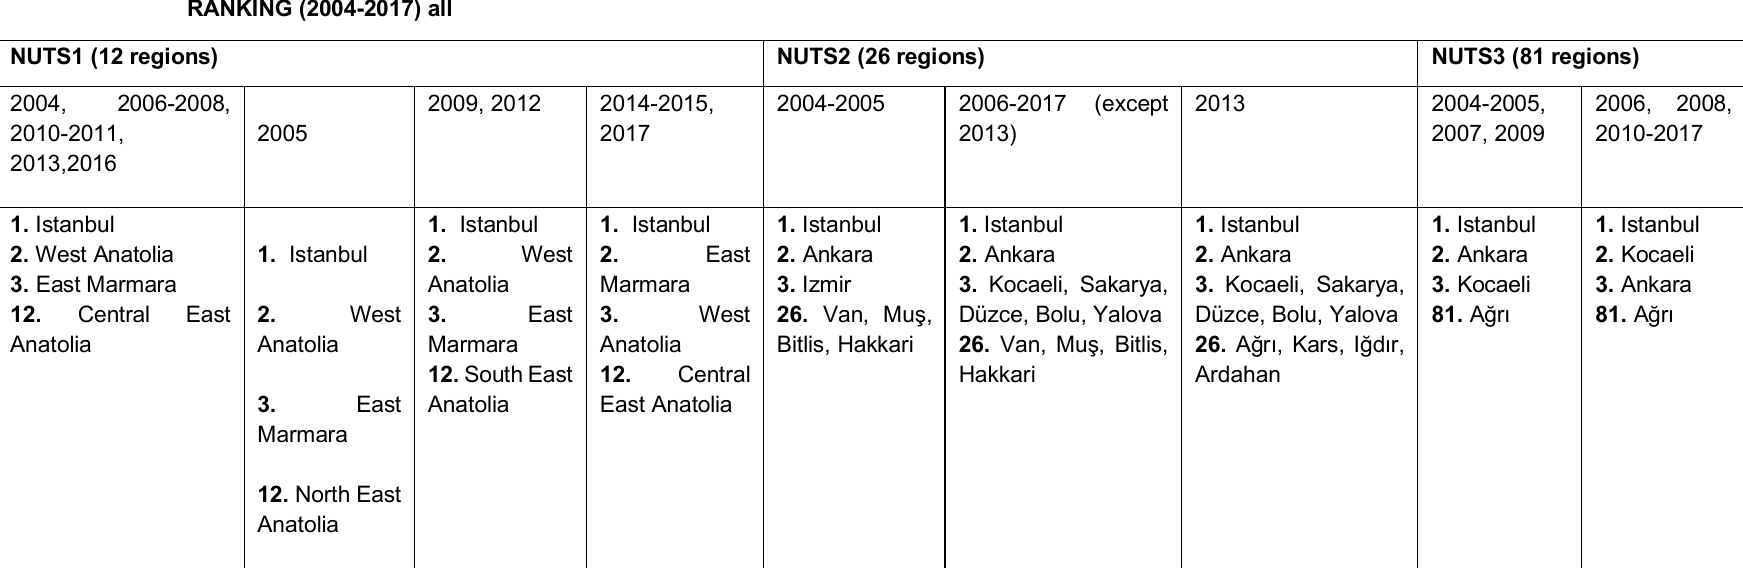
Table C.1: Ranking